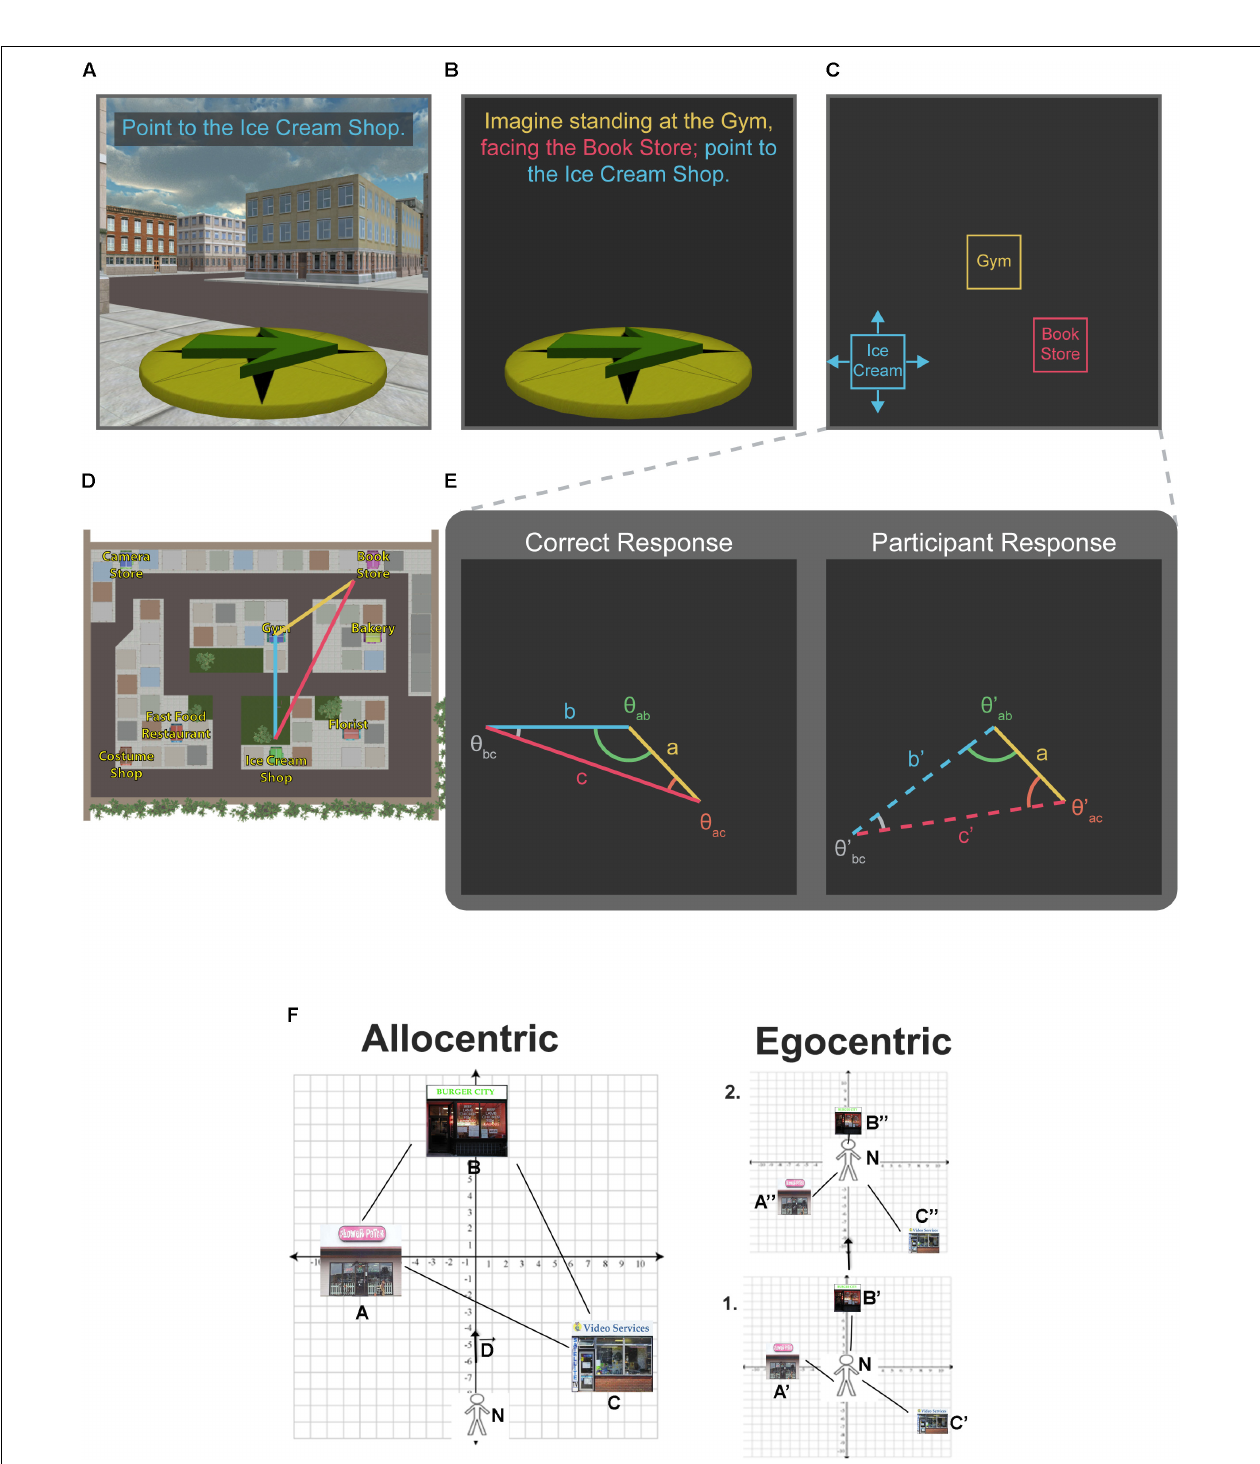
FIGURE 1 | Pointing tasks. Single-trial examples for computer versions of the scene and orientation-dependent (SOP) pointing task (A) , the judgments of relative direction (JRD) pointing task (B) , and the proposed relative vector discrimination (RVD) task (C) . In each example, participants’ memory for the location of the Ice Cream Shop (blue text) is being tested. Example trials are based on the virtual environment used by Starrett et al. (in press) (D) . Unlike the JRD and SOP tasks, which only yield angular precision estimates, the RVD task yields both angular and distance information [note that the anchor vector (yellow line) is common across the correct and participant response, and the placement of the target store establishes the remaining two legs of a triangle (red and blue lines)] (E) . A reproduction of Figure 1 from Ekstrom et al. (2017) shows the cartesian relationship between allocentric (left panel) and egocentric (right panel) as a displacement vector from the navigator (F)